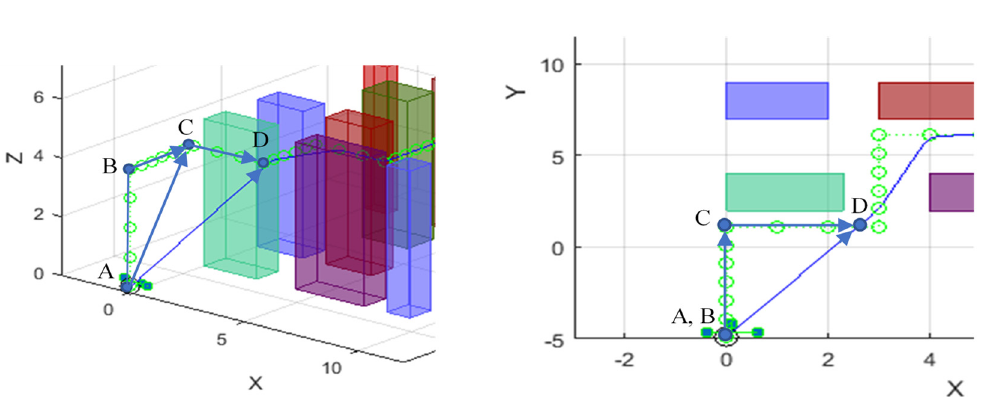
Figure 3. Various possible paths.